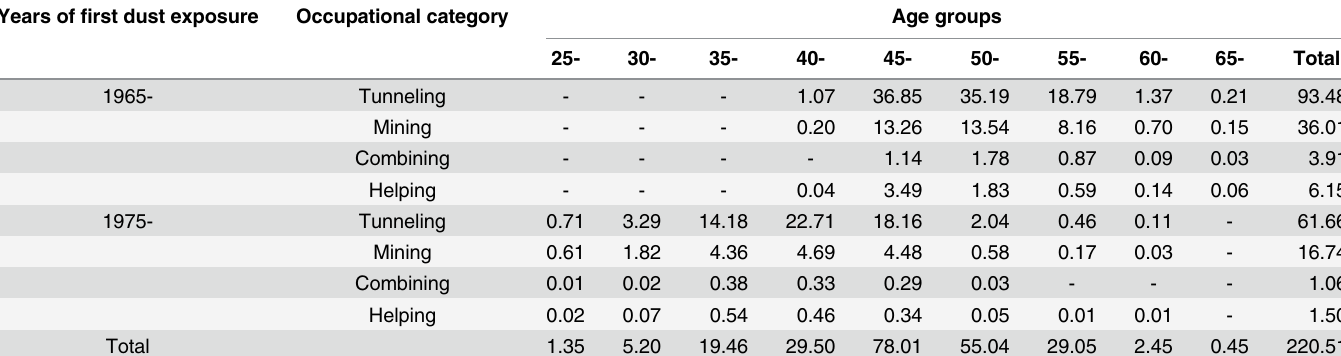
Table 3. Possible future CWP cases among redeployed coal workers by age group.